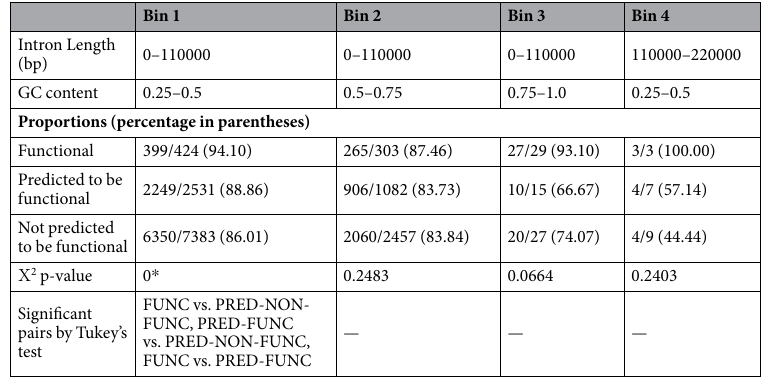
Table 4. Proportions of introns containing active genomic segments. Introns are separated to bins by their length and GC content. Only bins with representatives of all three intronic groups (FUNC, PRED-FUNC, PRED-NON-FUNC) are shown. χ 2 p-values are before correction. Values marked with * are significant after correction for multiple hypotheses.